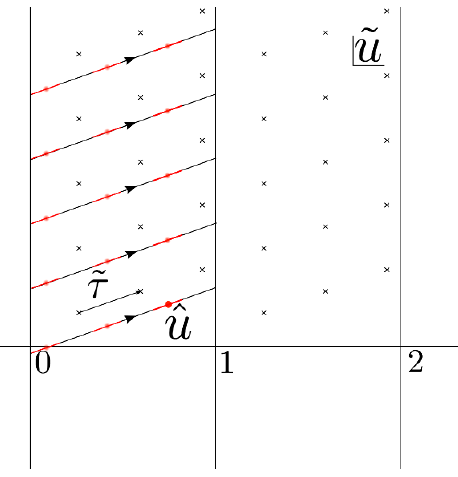
Figure 3 . Contour (cid:0) (cid:11) corresponding to a block B